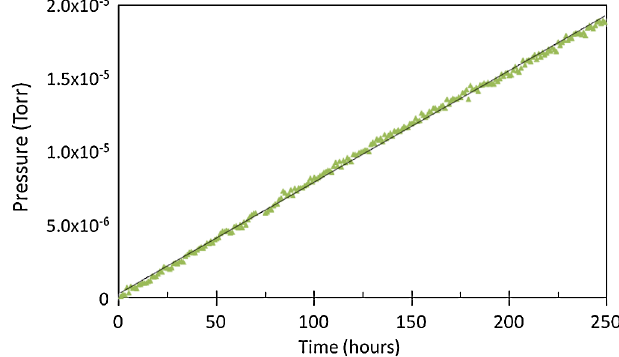
FIG. 3. (Color) Rate-of-rise plot showing pressure inside the unpumped gun high voltage chamber as a function of time, following the 400 (cid:2) C vacuum bakeout. Pressure was measured with a spinning rotor gauge. The outgassing rate of the vacuum vessel can be calculated from the slope of the line using Eq.